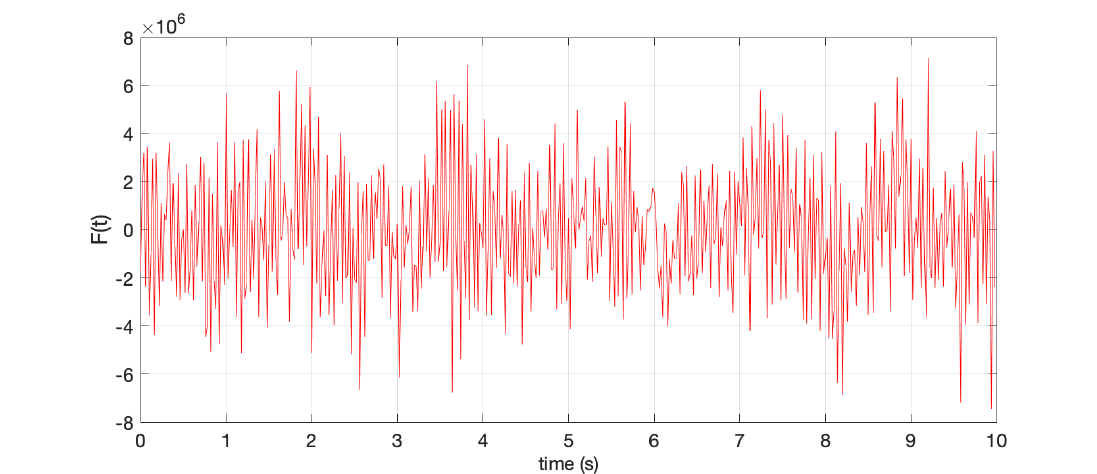
Figure 5. Loading involving a wider frequency